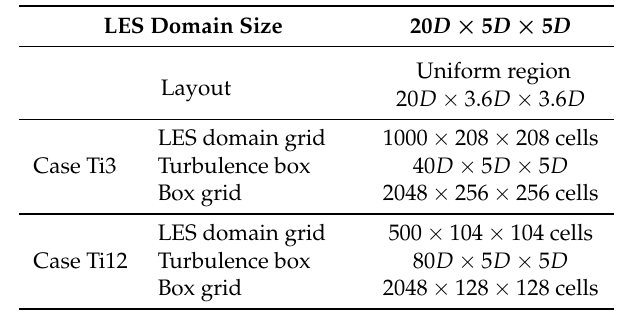
Table 2. Main parameters of the computational domains of LES and synthetic field (turbulence box). Dimensions of computational domains are given as L x × L y × L z with grids containing N x × N y × N z cells. Synthetic field domains are given as L B, x × L B, y × L B, z containing N B, x × N B, y × N B, z cells. Lengths measured in D = 0.1